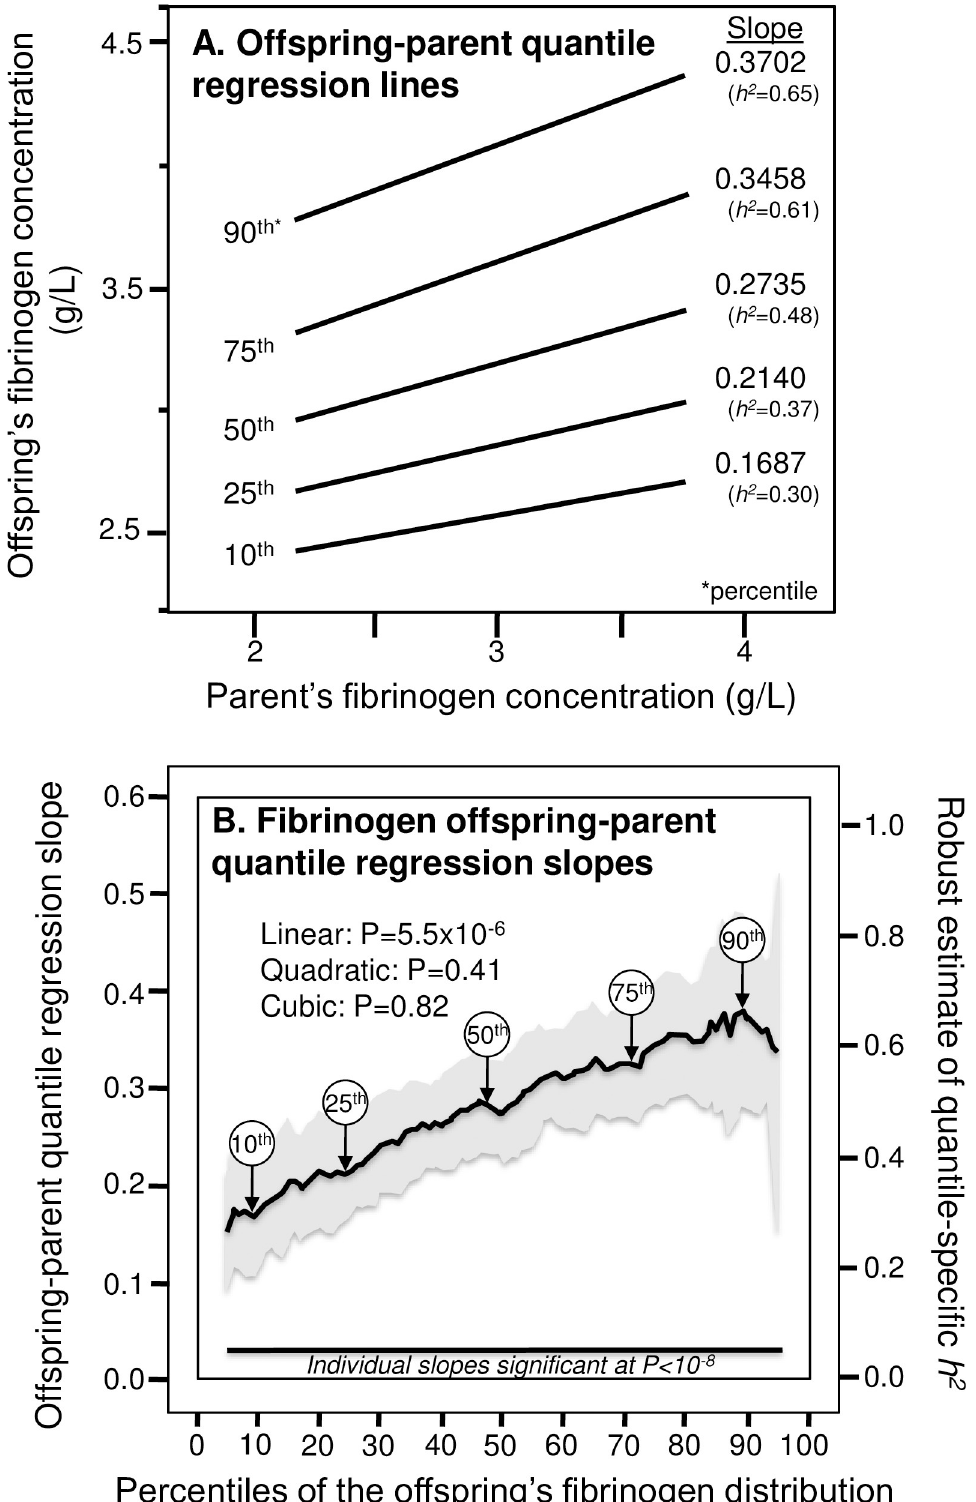
Fig 1. Quantile regression analysis of offspring-parent pairs. (A) Offspring-parent regression slopes ( β OP ) for selected quantiles of the offspring’s fibrinogen concentrations from 7769 offspring-parent pairs, with corresponding estimates of